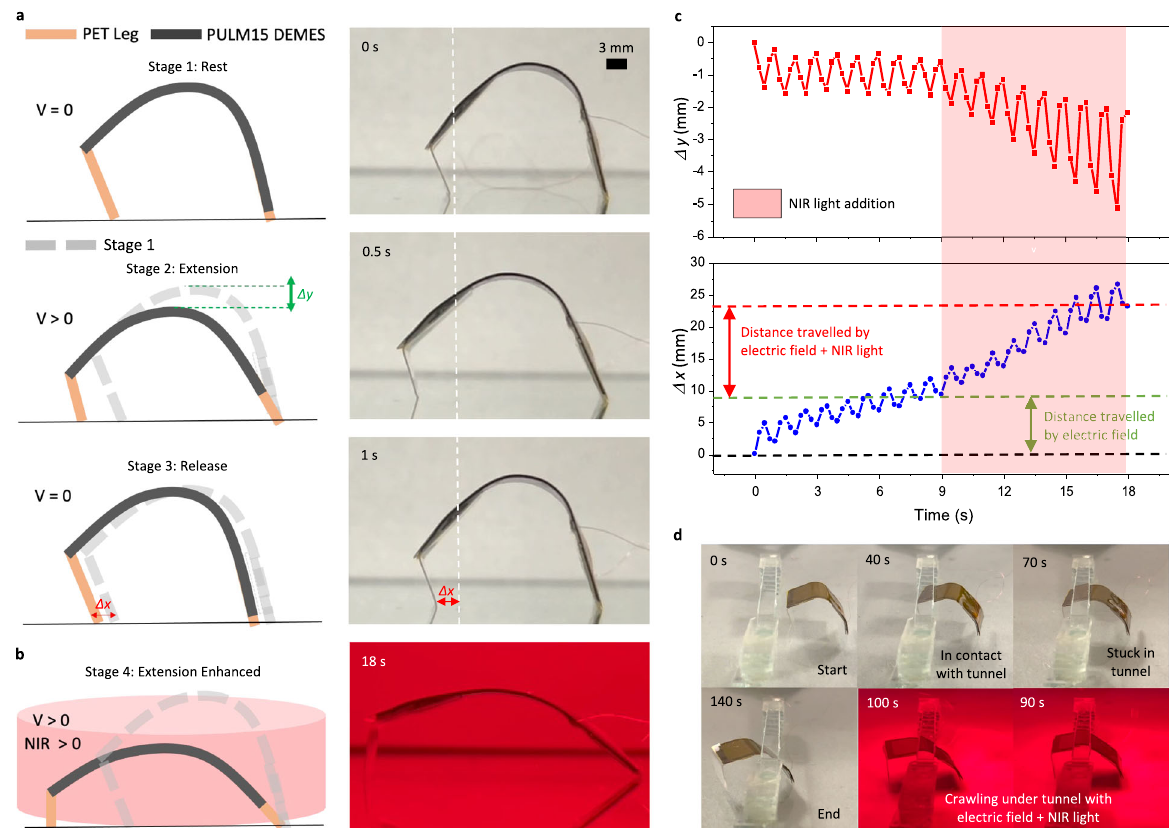
Fig.6|LocomotionanalysisofDEMEScrawler.a Schematicanddigitalimagesof the working principle of two-anchor crawling locomotion of a DEMES crawler. Whenavoltage( V )isapplied,thecrawler fl attensandextendstogiveavertical( Δ y ) and lateral displacement ( Δ x ). After the voltage is removed, asymmetric friction from the bent front PET leg enables the crawler to crawl forward. b Schematic and digitalimage ofthe usage of NIR light asa secondarycontrol to increase the stride of the crawler, with larger Δ x and Δ y . c Δ y and Δ x of two-anchor crawling loco- motion as a function of time. First, the crawler was driven by an electric fi eld of 35V μ m − 1 at1Hz.Afterwhich,NIRlight(0.4Wcm − 2